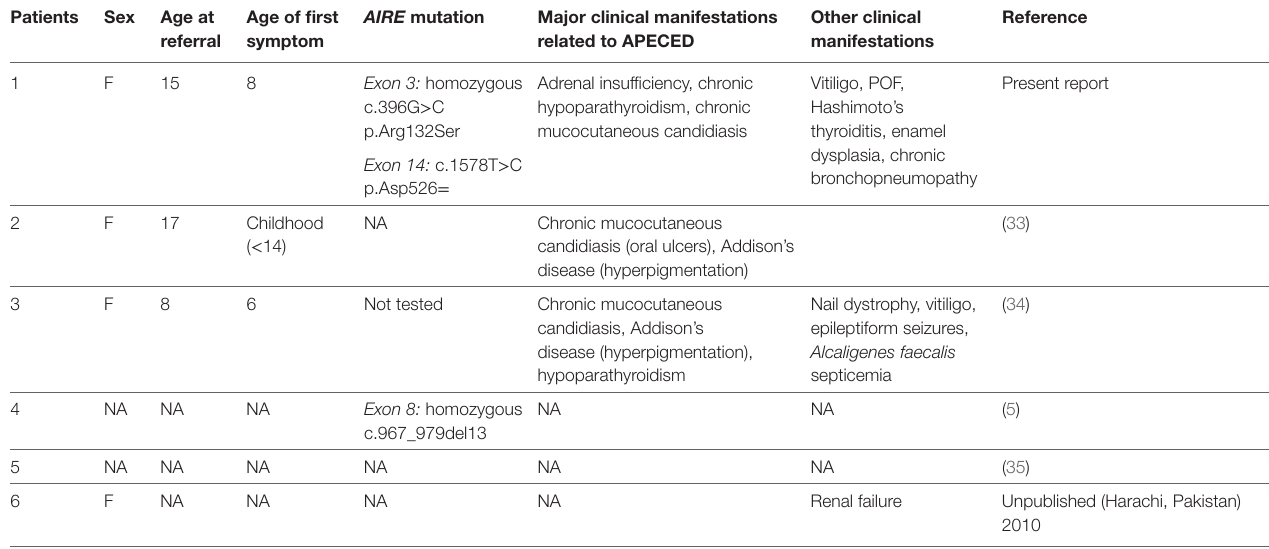
taBLe 2 | Clinical and genetic features of a small series of Pakistani APECED patients reported between 2006 and 2018 including the present case report.